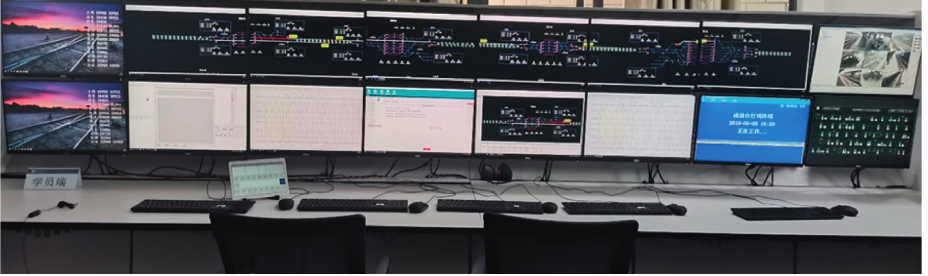
Figure 7: HSR dispatch simulator used to measure train delay time.